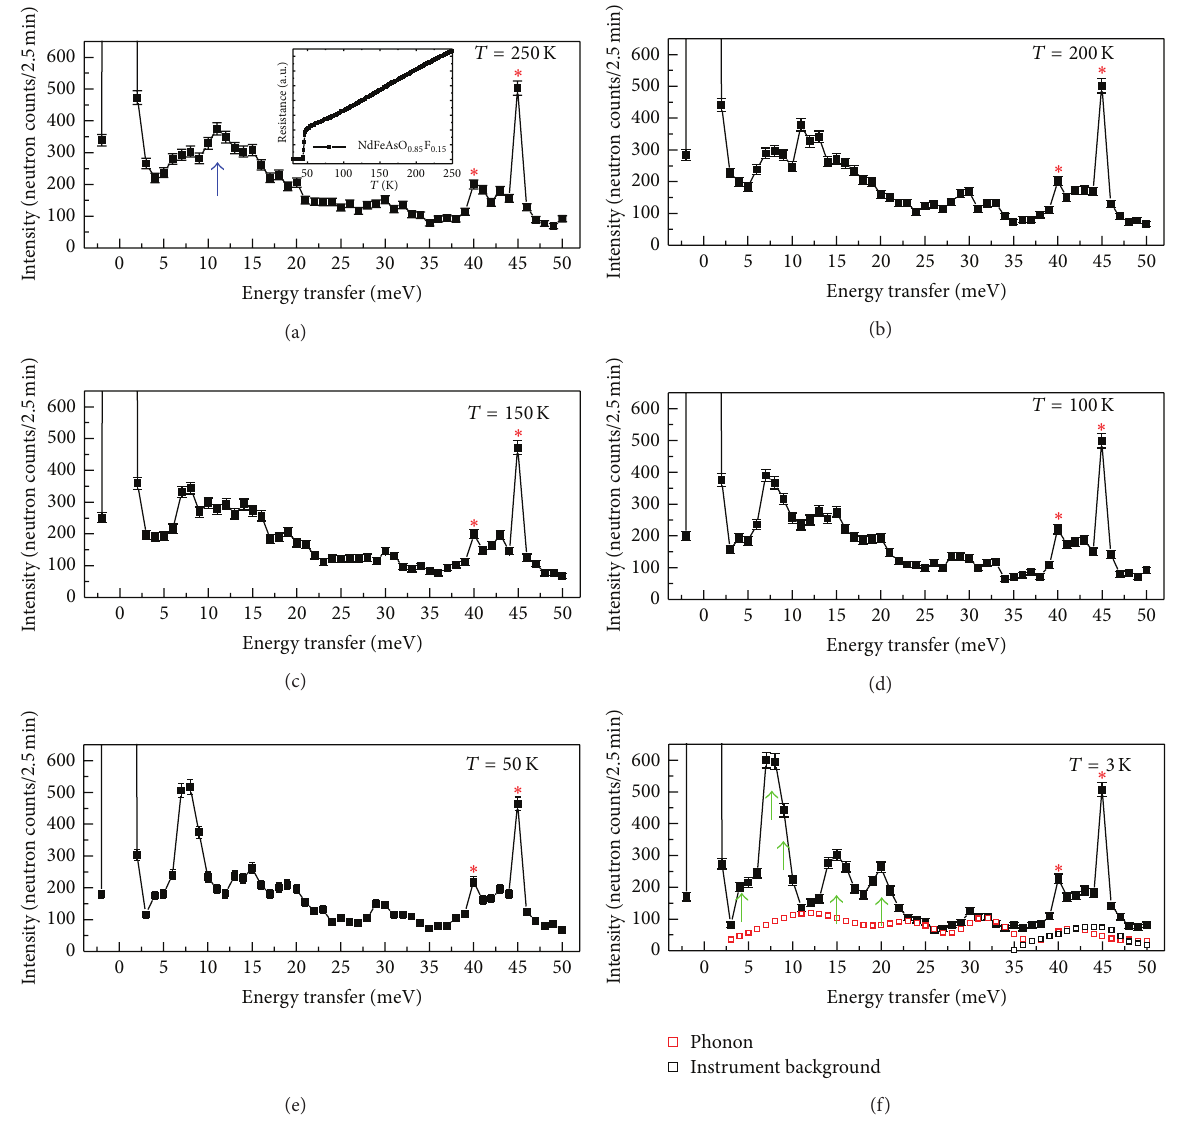
Figure 1: Inelastic neutron scattering spectra of NdFeAsO 0.85 F 0.15 were measured with fixed 𝐸 𝑓 = 14.7 meV and 𝑄 = 3.1 ˚A. The energy scans were carried out at temperatures from 3K to 250 K as marked on each figure. The solid lines are guides to the eye. The red stars marked the spurious peaks caused by the instrument setup. In the inset of Figure 1(a), the temperature dependence of resistance data of our samples is